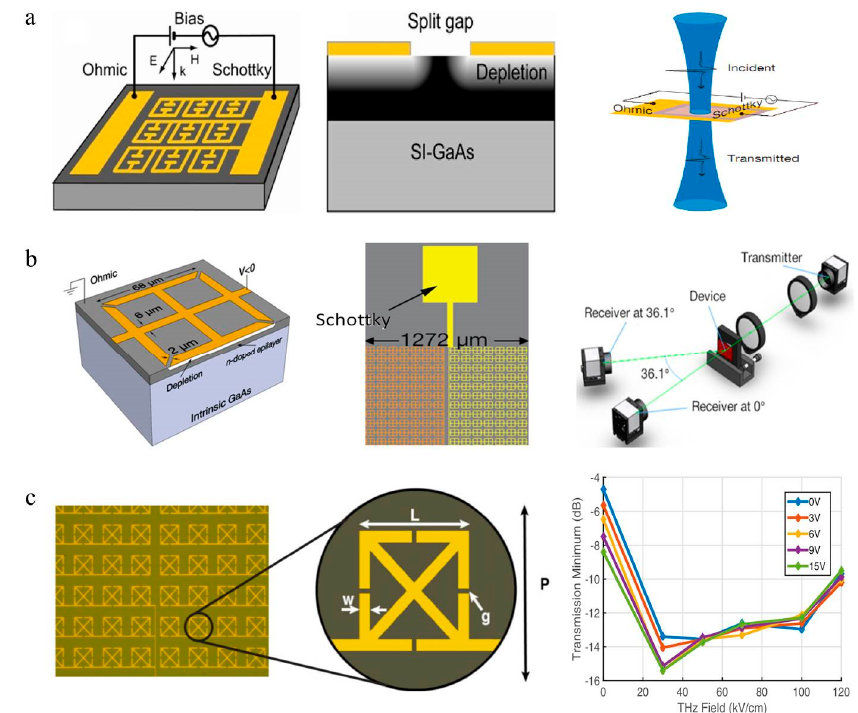
Figure 4. ( a ) Schematic of the THz metamaterial modulator. Reproduced with permission from [34], Copyright Springer Nature, 2006. ( b ) The di ff ractive modulator consists of 32 split ring resonator (SRRs) columns and a THz-TDS system is used to characterize the device. Reproduced with permission from [38], Copyright AIP Publishing, 2014. ( c ) Micrograph of the Metamaterial (MM) structure and incident THz field intensity influence transmission minimum at di ff erent applied DC biases. Reproduced with permission from [39], Copyright AIP Publishing,